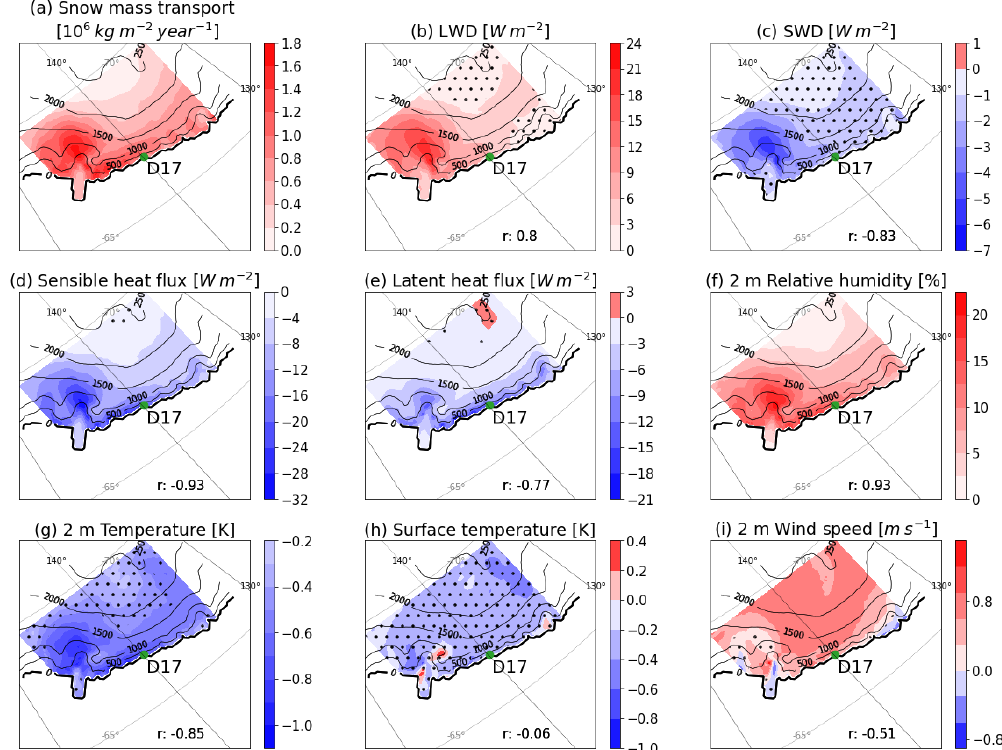
Figure 8. Annual mean (2010–2018) near-surface and surface variable modifications between MAR-DR and MAR-nDR over the integration domain. Within each panel, r indicates the Pearson correlation coefficient between the snow mass transport anomaly (a) and the considered variable (b–i) . Dotted areas designate areas where modifications are lower than interannual variability (taken as the standard deviation computed from annual